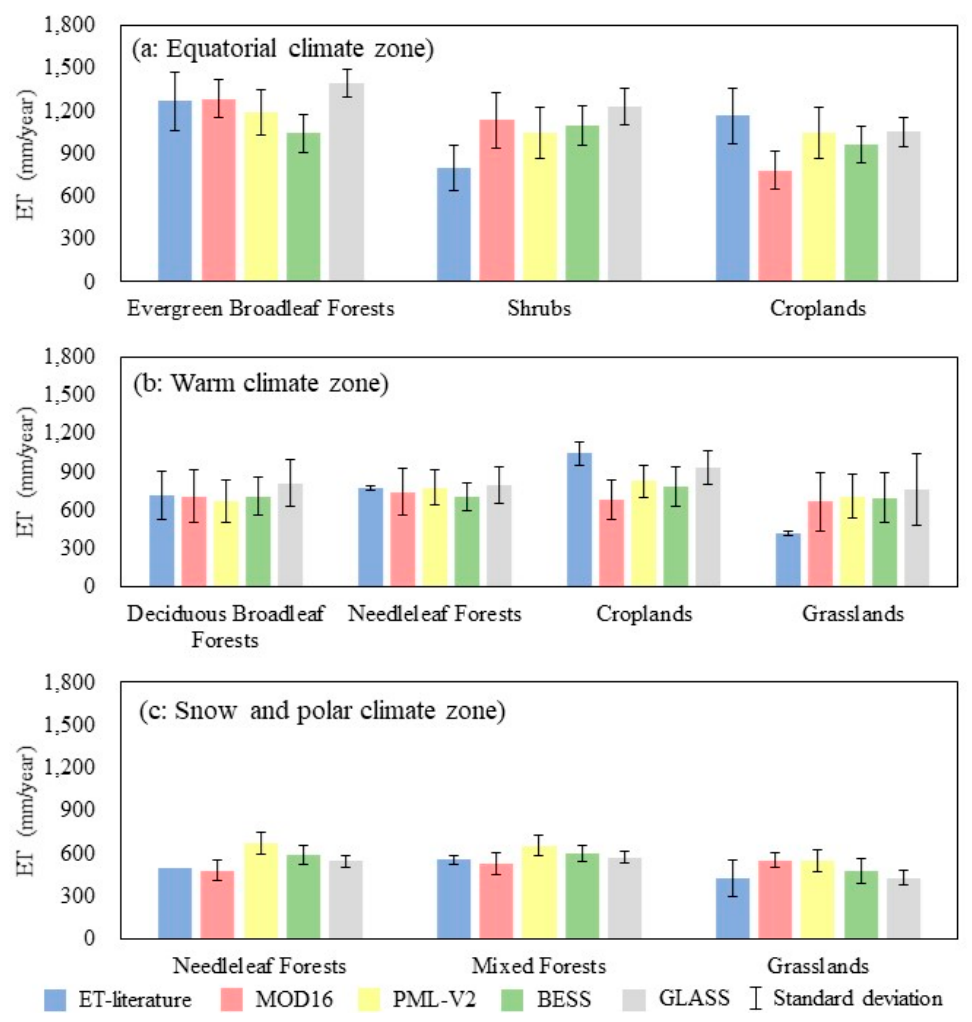
Figure 8. Comparison of multi-year average ET from equatorial climate zone ( a ), warm climate zone ( b ), and snow and polar climate zone ( c ) among the four products and ET values from literature in other regions.